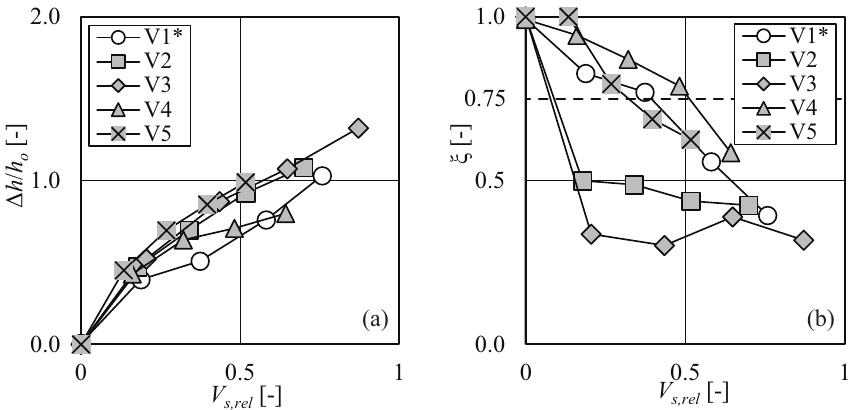
Figure 5. ( a ) Relative backwater rise ∆ h / h o and ( b ) bedload transport reduction factor ξ versus V s , rel for tests V1* ( ρ L = 500 kg/m 3 ), V2 ( ρ L = 700 kg/m 3 ), V3 ( ρ L = 800 kg/m 3 ), V4 ( ρ L = 900 kg/m 3 ), and V5 ( ρ L = 1100 kg/m 3